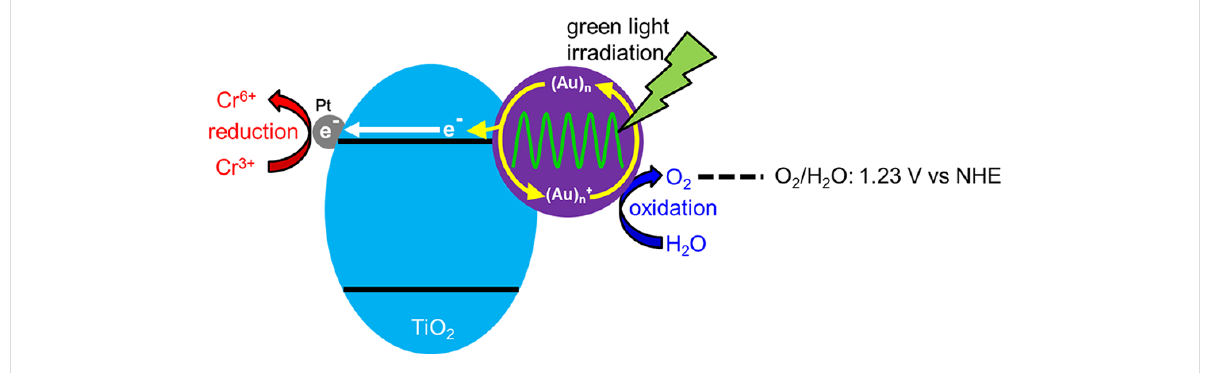
Figure 10: Mechanism of reduction of Cr(VI) using a Au/TiO 2 − Pt plasmonic photocatalyst under visible-light irradiation. Reprinted with permission from [221], copyright 2013 American Chemical Society.